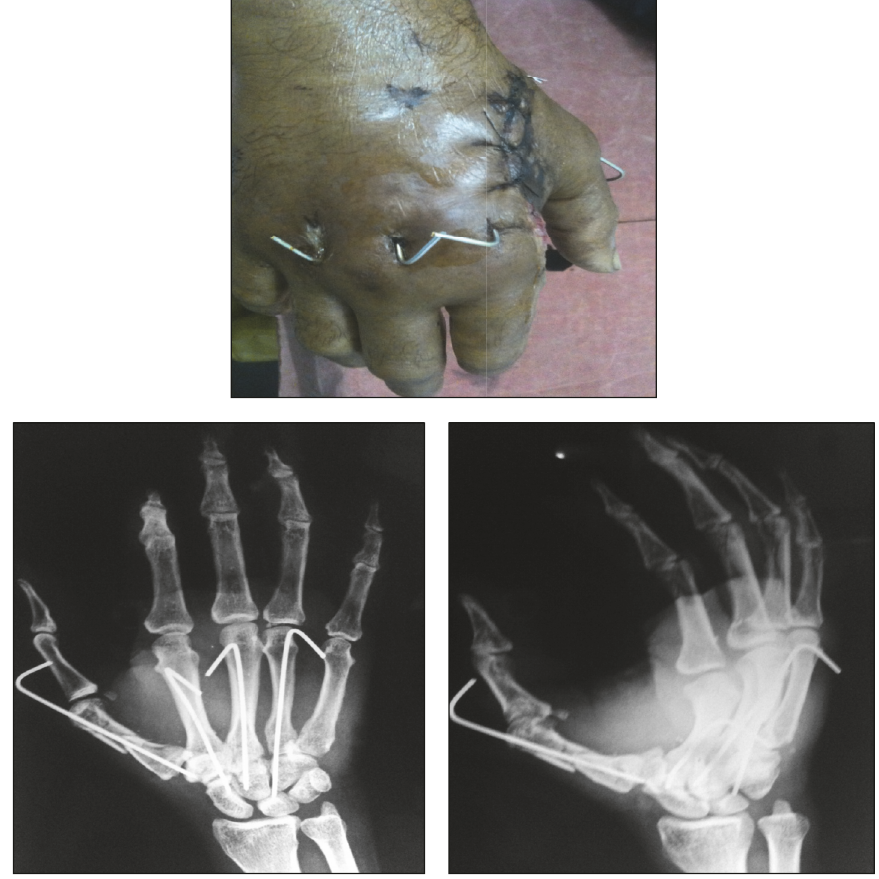
Figure 3: Clinical picture and X-ray at 2 weeks.